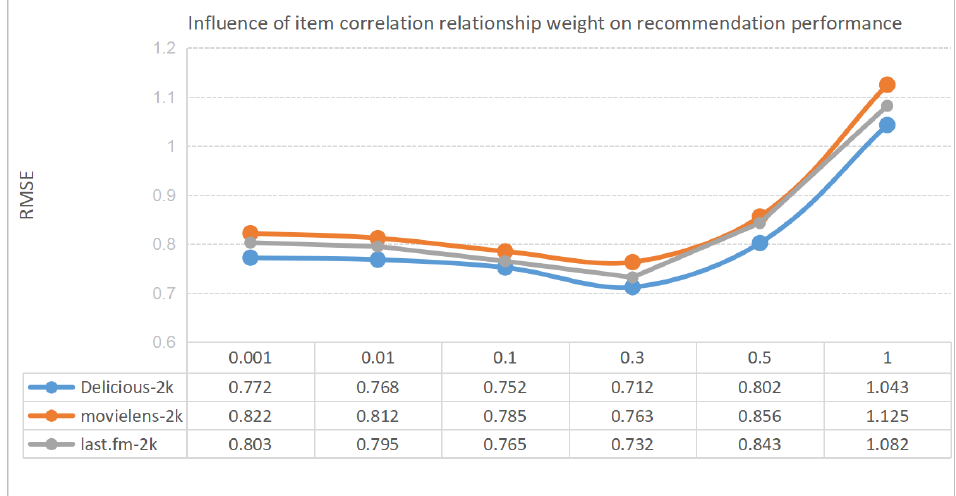
Figure 7. Influence of item correlation relationship weight on recommendation performance.